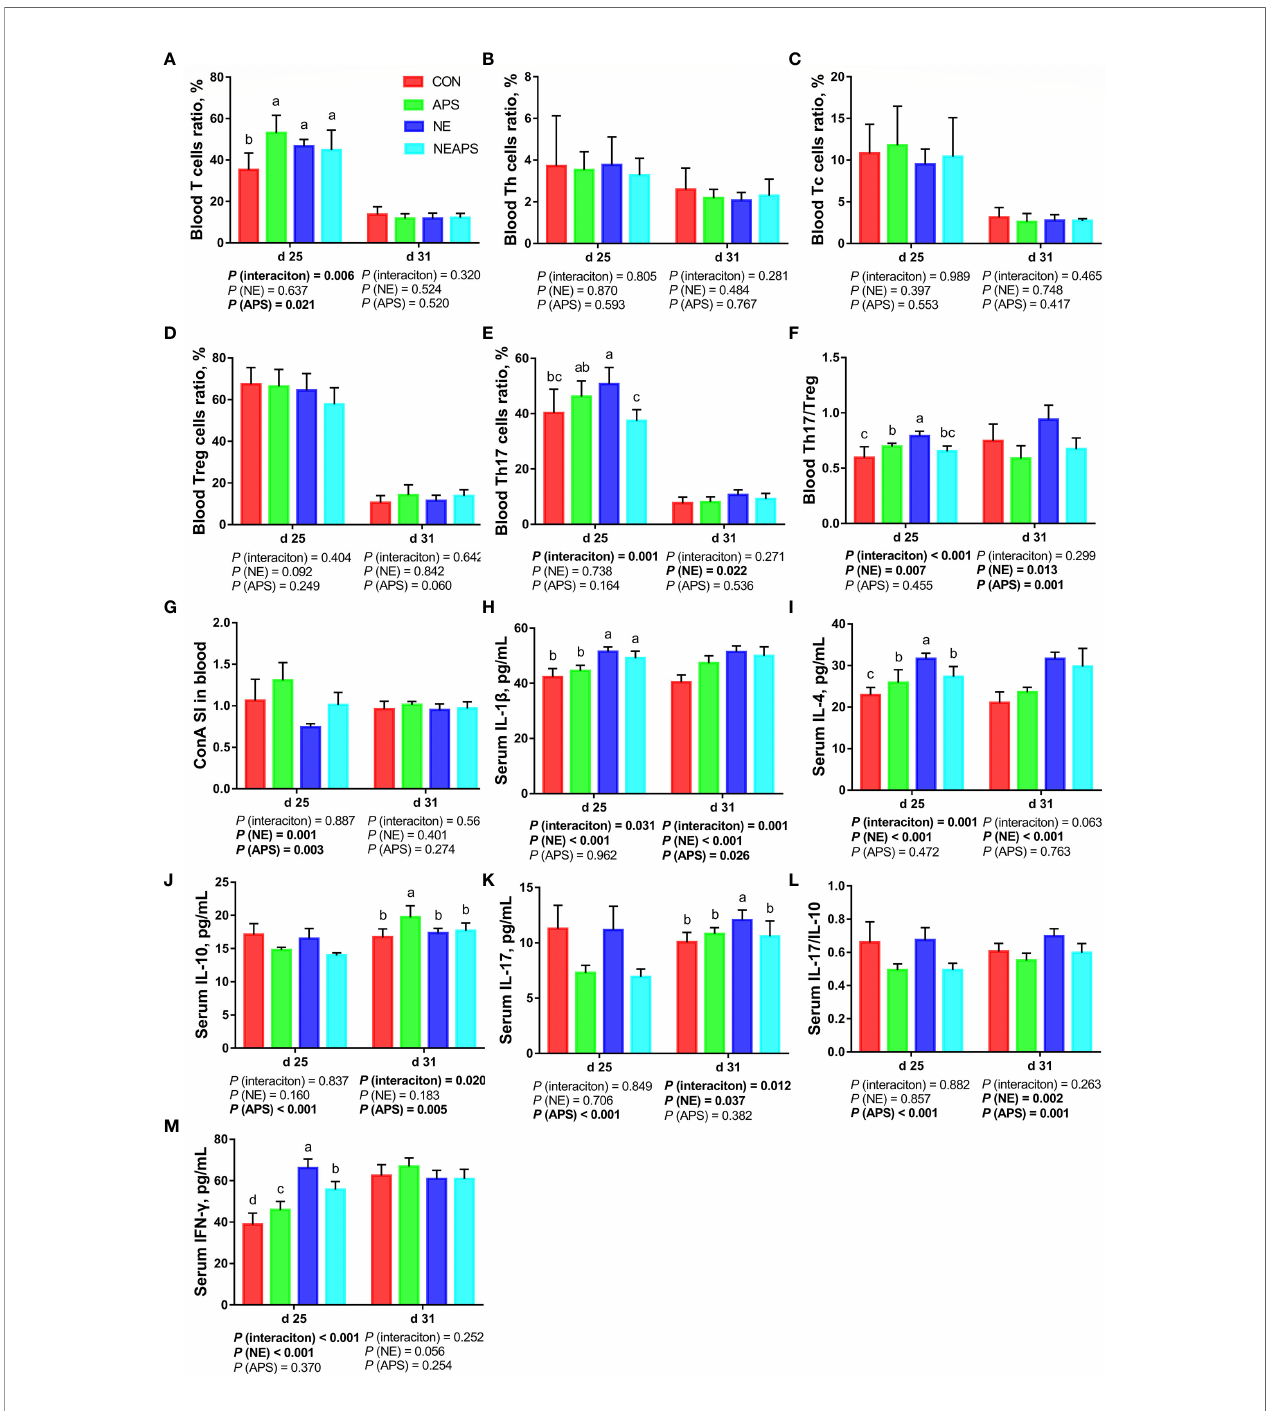
FIGURE 3 | Effects of dietary astragalus polysaccharides supplementation on peripheral cellular immune function of broiler chickens challenged with necrotic enteritis. The frequencies of T (A) , Th (B) , Tc (C) , Treg (D) and Th17 (E) of peripheral blood lymphocytes were analyzed by fl ow cytometry. The Th17/Treg (F) of peripheral blood lymphocytes was calculated by dividing the proportion of Th17 cells by the proportion of Treg cells. Peripheral blood lymphocytes were stimulated with concanavalin A (ConA) (G) , and the stimulation index (SI) was calculated as described in the Materials and Methods section. The levels of IL-1 b (H) , IL-4 (I) , IL-10 (J) , IL-17 (K) , IL-17/IL-10 (L) and IFN- g (M) in serum were analyzed by ELISA kit. All graphs are presented as mean, with the standard deviation (SD) shown via the whiskers. The main effect and interaction effects were analyzed using the general linear model (GLM) procedure, with the P values for the main effects written out below each plot. The one-way ANOVA and multiple comparisons were performed when interactive effects differed signi fi cantly. The lowercase letters on the bar charts indicate signi fi cant differences ( P < 0.05). CON, control group; APS, APS group; NE, NE infection group; NEAPS, APS infected with NE